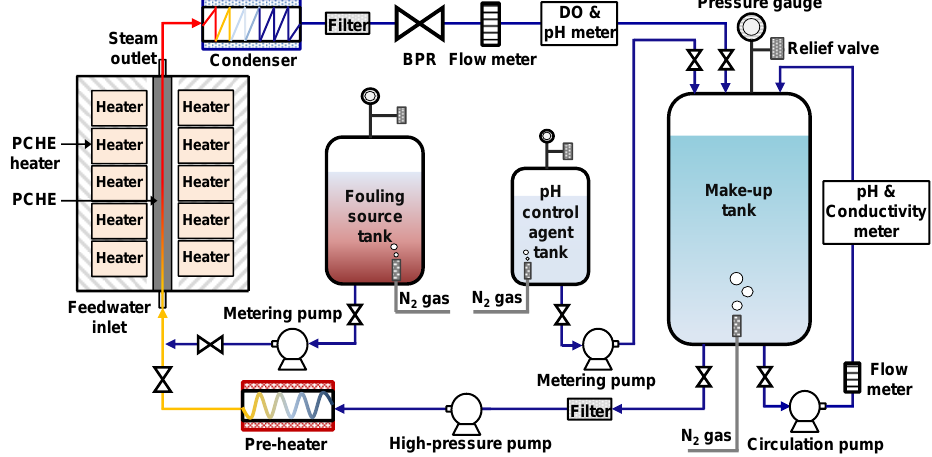
Figure 2. Schematic diagram of the circulation loop system for the PCHE fouling test. Table 1. Thermal hydraulic parameters and water chemistry conditions for the fouling test.